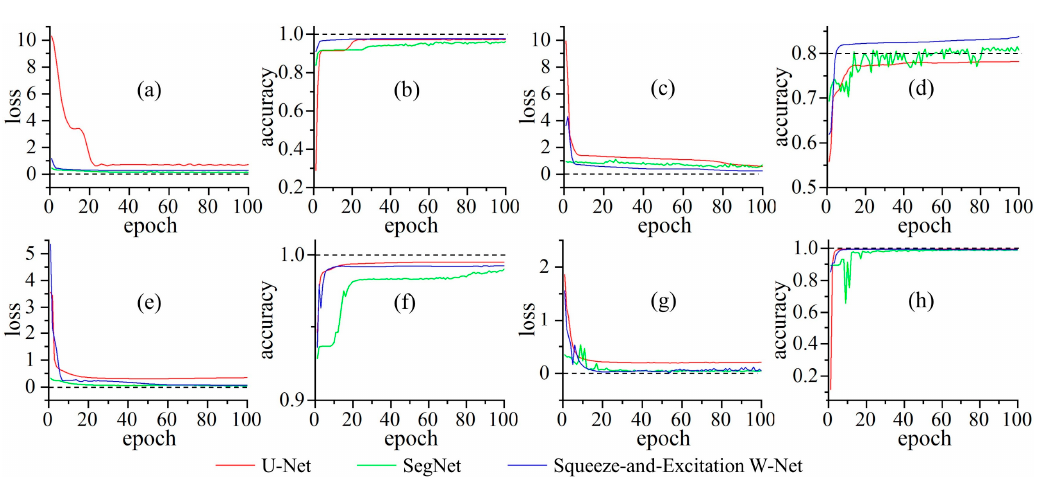
Figure 13. Validation accuracy and loss curve of U-Net, SegNet, and squeeze-and-excitation W-Net, for experiment 1 ( a , b ), experiment 2 ( c , d ), experiment 3 ( e , f ), and experiment 4 ( g , h ).